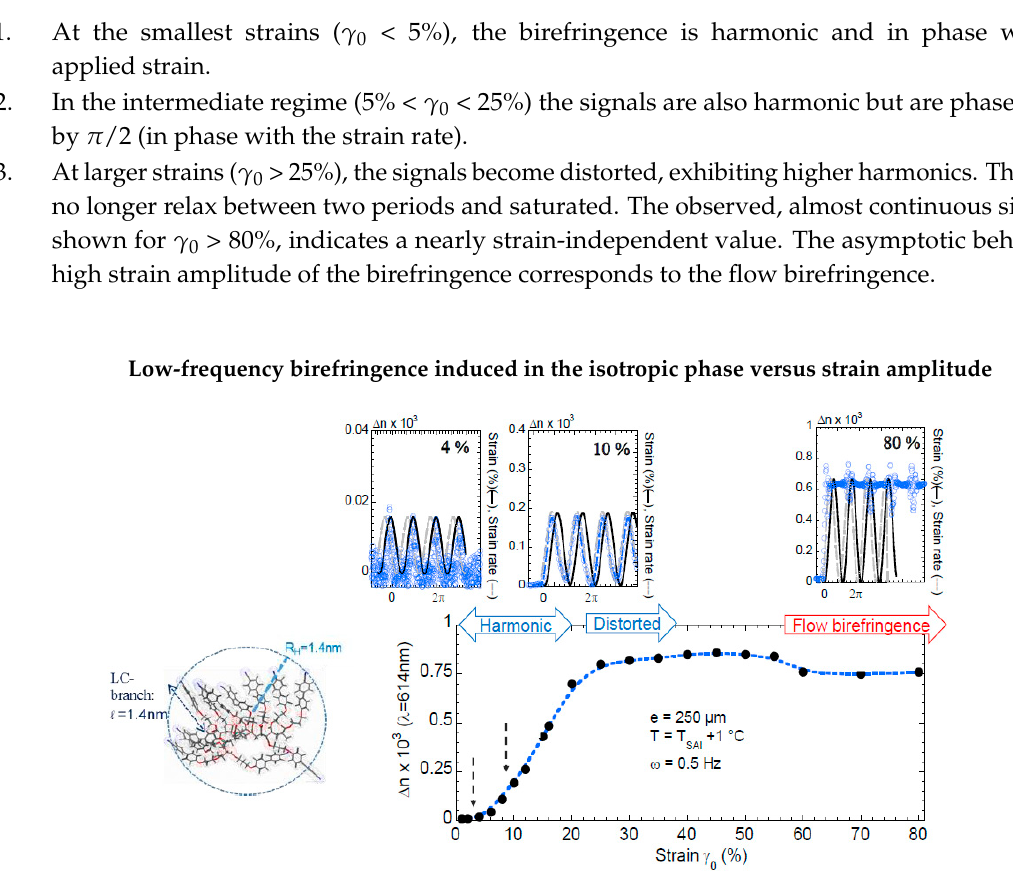
Figure 3. Strain dependence of the birefringent signal (peak value of the signal) in the isotropic phase of the 12-units liquid crystal (T-TS AI = +1 °C, quartz substrate) at 0.5 Hz. The strain amplitude is the maximum displacement length δ l divided by the sample thickness ( γ 0 = δ l / e ). The oscillatory signals at γ 0 = 4%, 10%, and 80% strain amplitude displayed at the top (the applied strain is represented by the continuous black sine wave) indicate that: At a very low strain regime ( γ 0 < 4%), the birefringent signal is in phase with the applied strain wave (upper left inset).